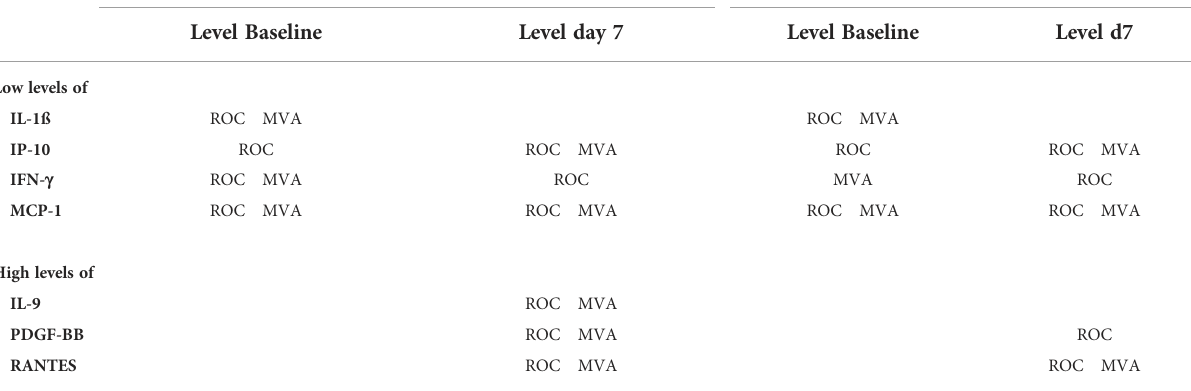
TABLE 3 Summary of cytokines with signi fi cant results for cytokine levels at baseline and on day 7 for the primary endpoint or the key secondary endpoint “ time to clinical improvement ” in both the ROC analysis and the multivariate models. Primary Endpoint:(survival and no longer severe COVID-19 on Key secondary endpoint:time to clinical day 21)